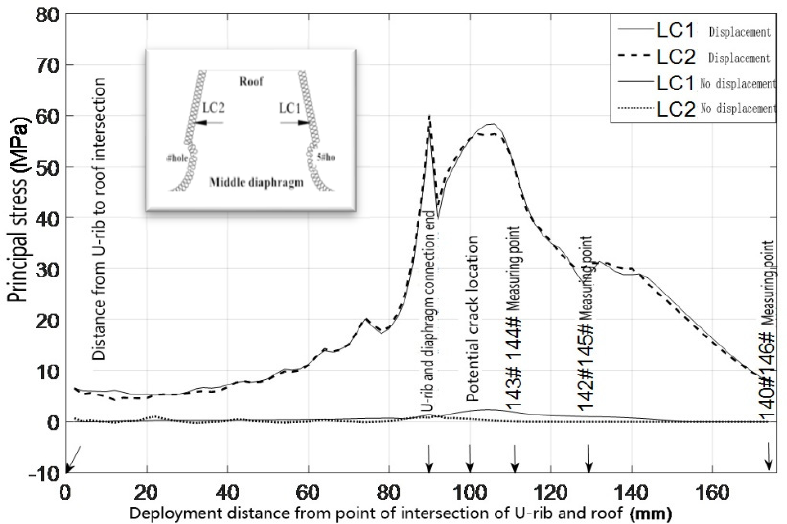
Figure 5. Principal stress distribution around the left side of 4# hole and the right side of 5# hole in diaphragm.